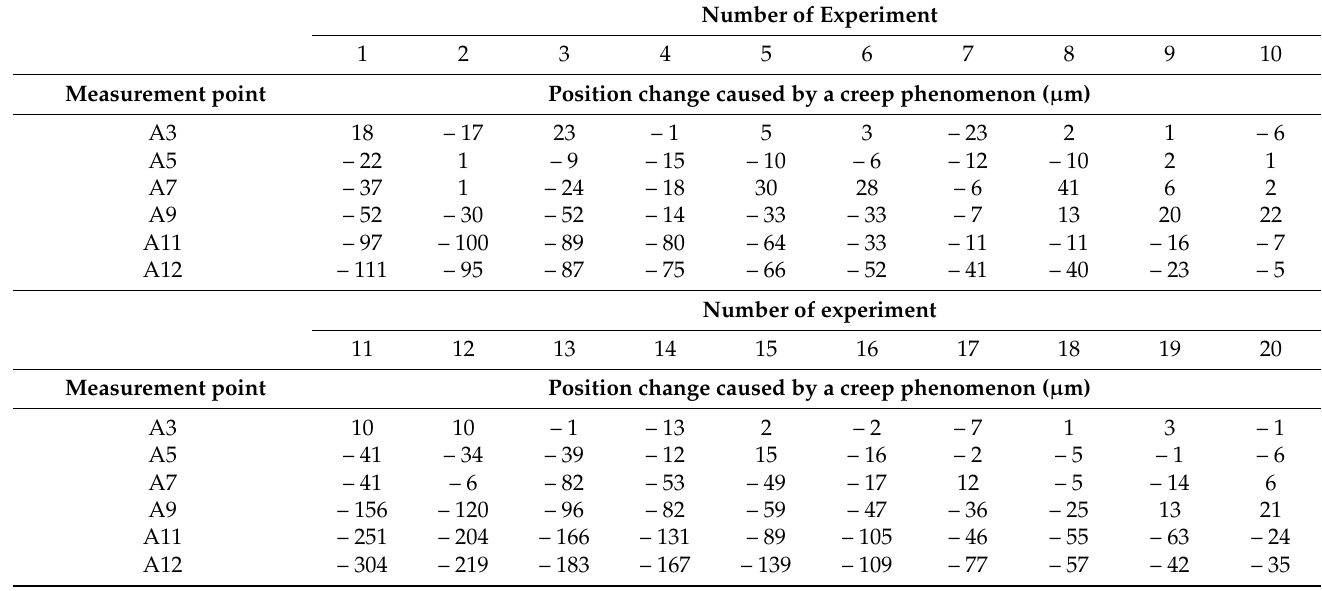
Table 3. Position changes of measurement points in laboratory experiments.